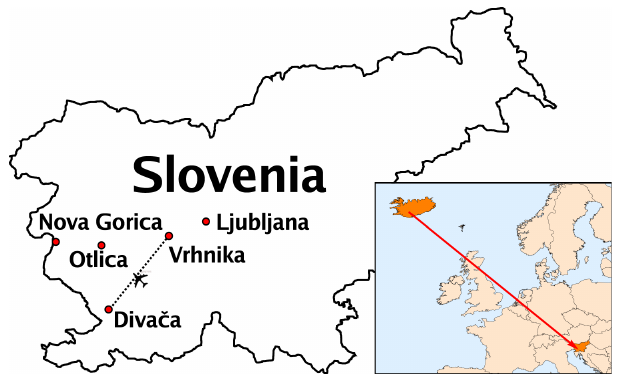
Fig. 1. Map of Slovenia indicating the measuring locations of the campaign. At Nova Gorica and Otlica lidar-based remote sensing were performed. Ground-based in-situ measurements were done in Ljubljana and airborne in-situ measurements were performed dur- ing the aircraft ascent at Diva ˇ ca, descent at Vrhnika and during the flight from Divaˇca to Vrhnika (dashed line). The inlaid map of Eu- rope indicates the position of Slovenia and